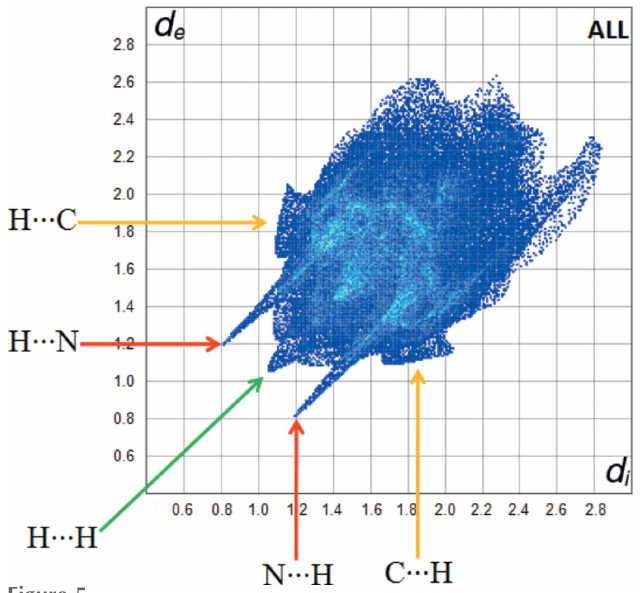
Figure 5 Fingerprint plot of the title compound.